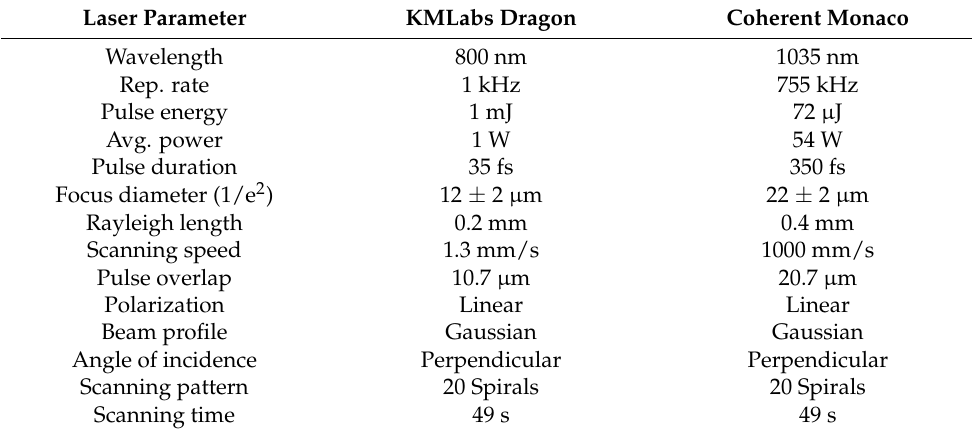
Table 1. Laser parameters used during